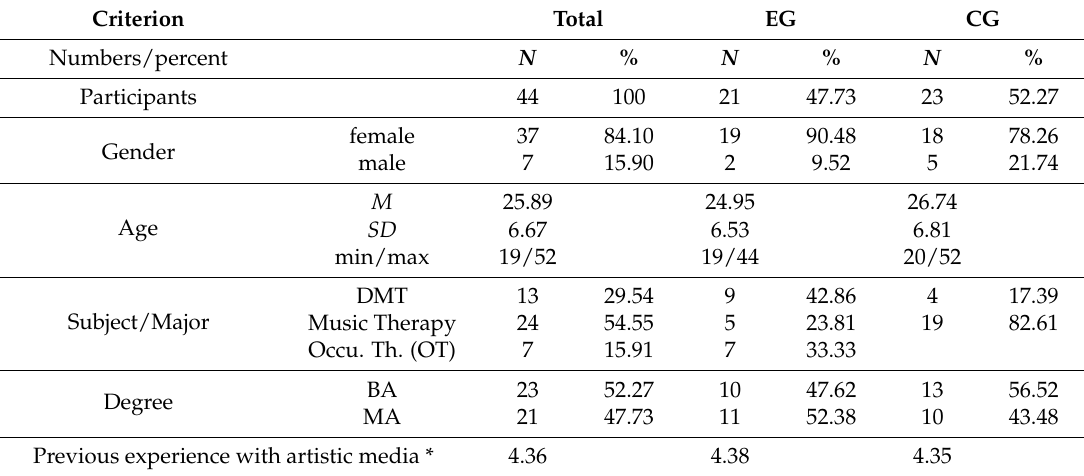
Table 1. Demographic data of